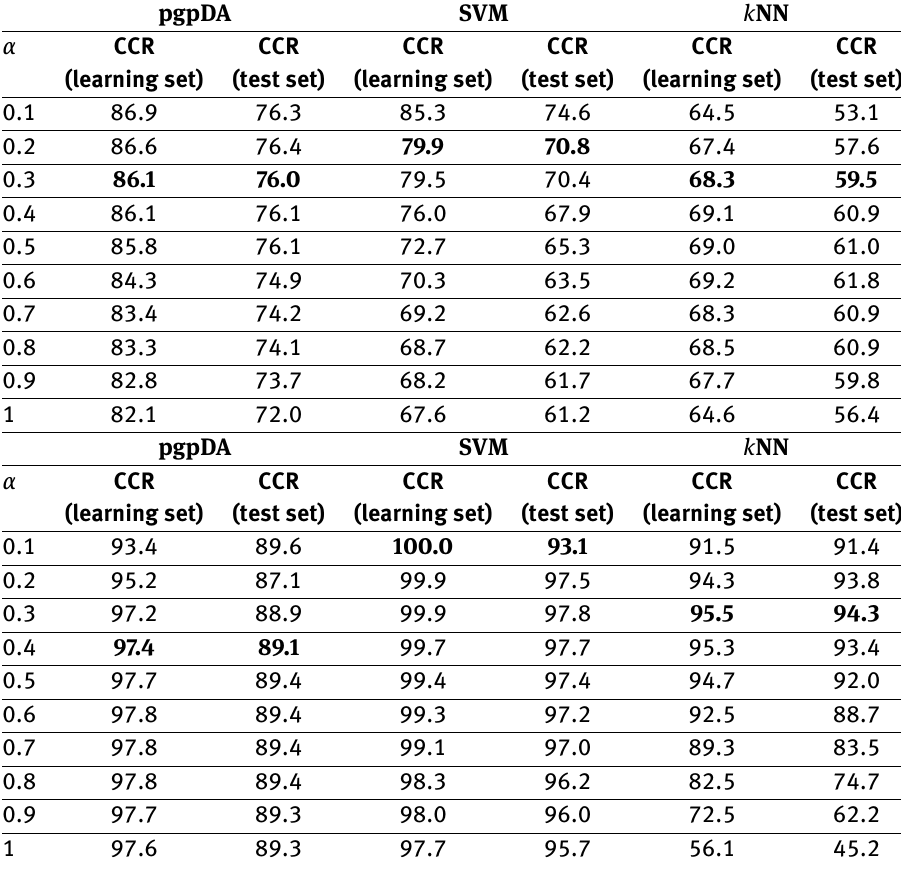
Table 3: Correct Classification Rate (CCR) on the verbal autopsy dataset (top) and on the handwritten digit dataset (bottom). Sylla & Girard kernel is plugged into pgpDA, SVM and k NN methods for α ∈ { 0.1, 0.2, . . . , 1 } . The CCR associated with the parameter α * selected by the double cross-validation procedure is emphasized. The train set includes τ = 63% individuals from the initial dataset.